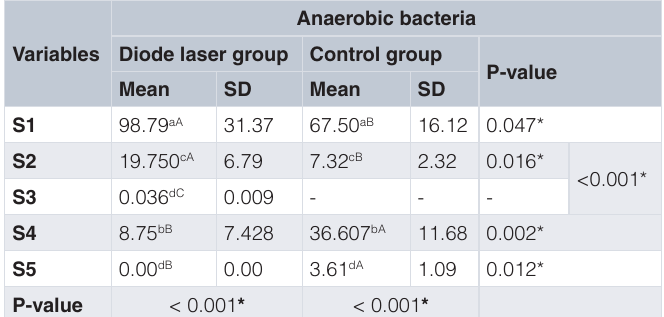
Table 5. Mean and standard deviation values of the bacterial count (CFU/ml ×10 4 ) of anaerobic bacteria of different